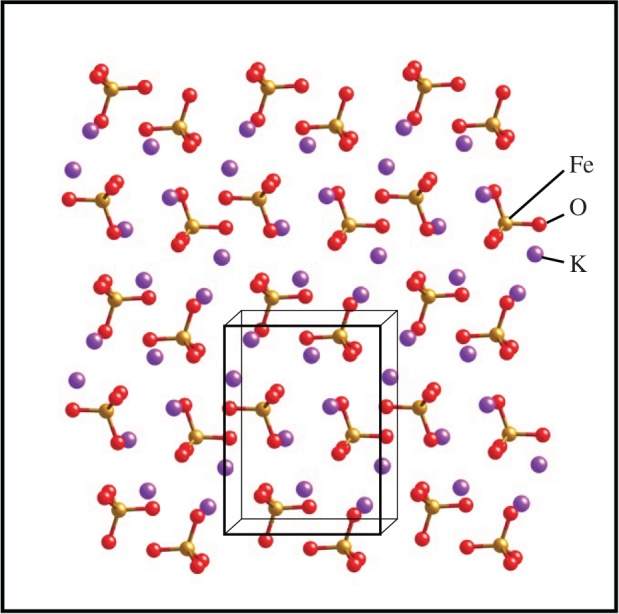
The orthorhombic crystalline of K2FeO4.